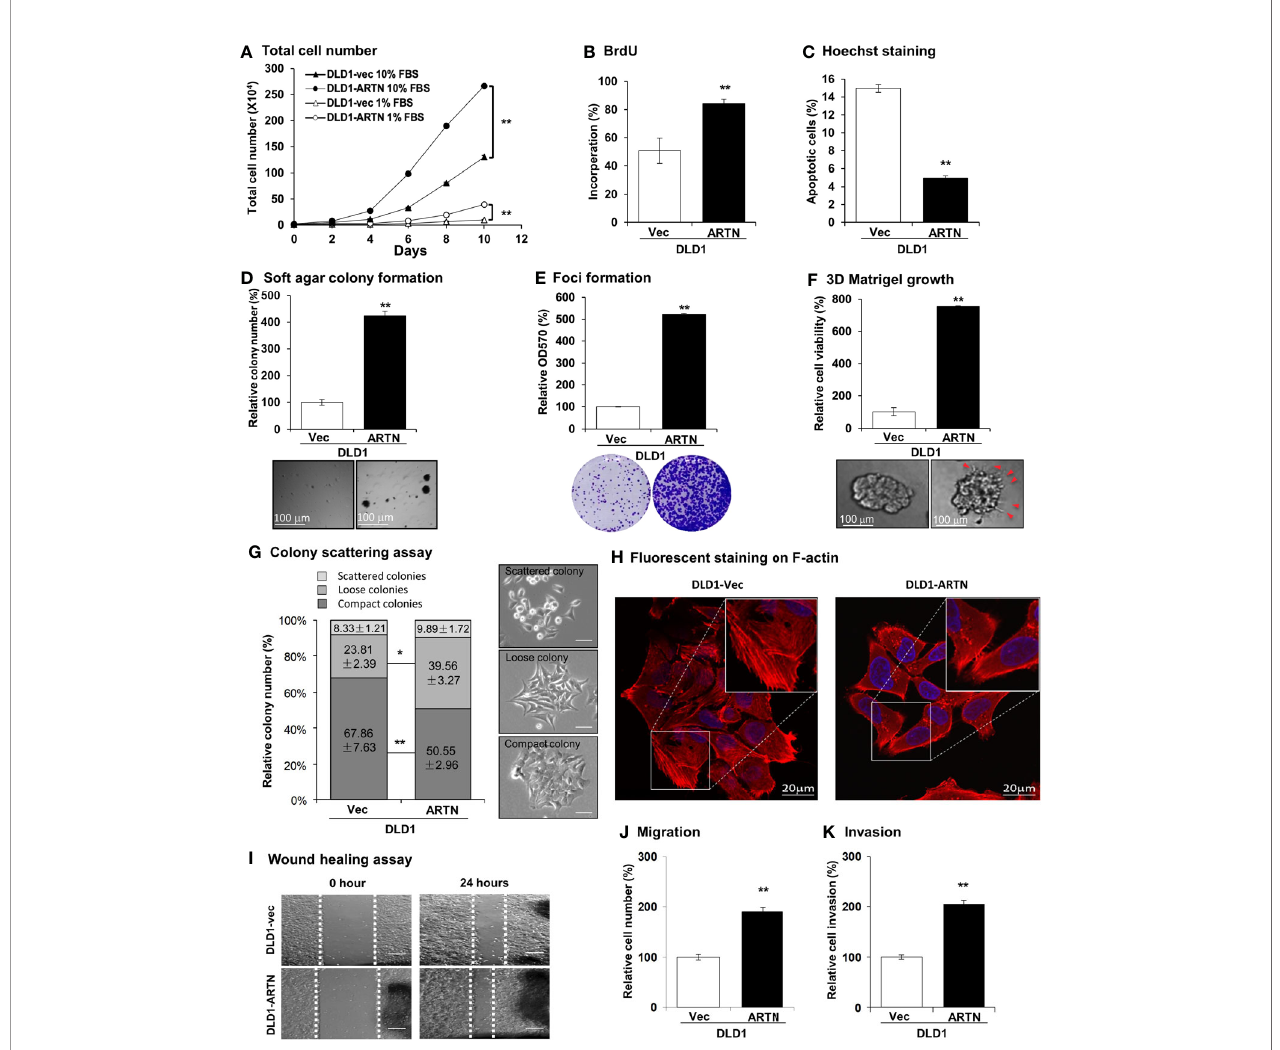
FIGURE 2 | Forced expression of ARTN enhances oncogenic behaviour of CRC cells. (A) Total cell number of DLD1-vec and DLD1-ARTN cells under normal culture condition (medium with 10%FBS) or serum deprivation condition (medium with 1% FBS). (B) BrdU incorporation assay determined S-phase entry of DLD1- vec and DLD1-ARTN cells cultured under serum deprivation condition for 24 hours. (C) Hoechst 33258 staining determined apoptotic nuclei percentages of DLD1- vec and DLD1-ARTN cells cultured under serum deprivation condition for 24 hours. (D) Soft agar colony formation of DLD1-Vec and DLD1-ARTN cells. The colony numbers were counted and presented as relative percentage change. (E) Foci formation by DLD1-Vec and DLD1-ARTN cells under serum deprivation conditions for 14 days. At the end of the culture period the colonies were fi xed and stained with crystal violet (lower panel), which were then dissolved in 10% SDS and quanti fi ed at 570nm absorbance. (F) 3D Matrigel growth of DLD1-Vec and DLD1-ARTN cells. Cell viability was measured by AlamarBlue assay and presented as the relative percentage changes. Red arrowheads indicate the colony cell protrusions into the matrix. (G) Colony scattering assay of DLD1-Vec and DLD1-ARTN cells. The numbers of each type of colonies were calculated under microscope and presented as the percentages of the total counted colony numbers. Representative images of the colony morphology of each colony type of DLD1 cells are presented on the right. Scale bar, 100µm. (H) F-actin stained with Rhodamine-Phalloidin in the DLD1-Vec and DLD1-ARTN cells. The primary images (upper panel) were taken with confocal microscope at 1000X magni fi cation and zoomed in at the area in the white square as shown in the lower panel. Scale bar, 20µm. (I) Wound-healing assay by DLD1-Vec and DLD1-ARTN cells under serum deprivation conditions for 24 hours. The edges of the wound scratches were indicated with dotted guidelines. (J) Transwell migration assay of DLD1-Vec and DLD1-ARTN cells. (K) Transwell invasion assay of DLD1-Vec and DLD1-ARTN cells. * p < 0.05, ** p <